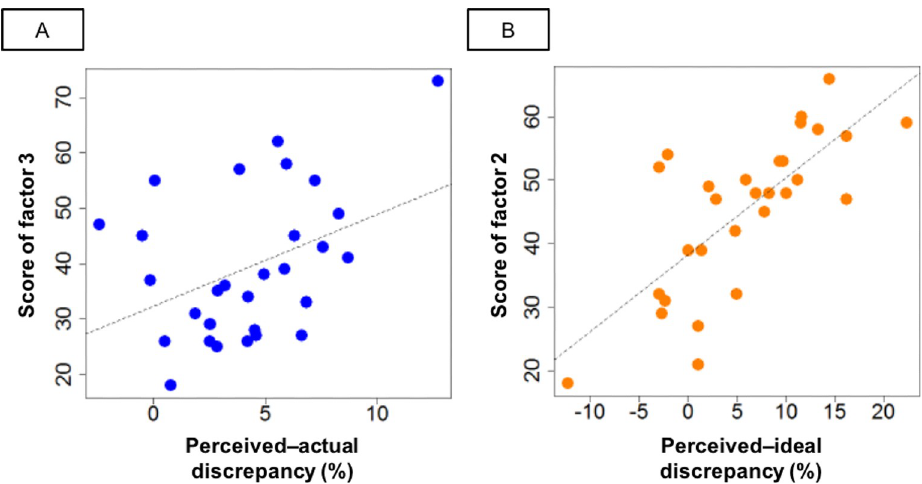
Fig 4. Scatterplot between perceived–actual discrepancy and factor 3, and of perceived–ideal discrepancy and factor 2. Simple correlation analyses between perceived–actual discrepancy and factor 3 (A), and of perceived–ideal discrepancy and factor 2 (B), were performed for illustrative purposes, while the results of the partial correlation analysis were subjected to further statistical tests. The correlation coefficients were r = 0.51 (p = 0.013) and r = 0.52 (p = 0.013), respectively. Both correlations remained significant after Bonferroni